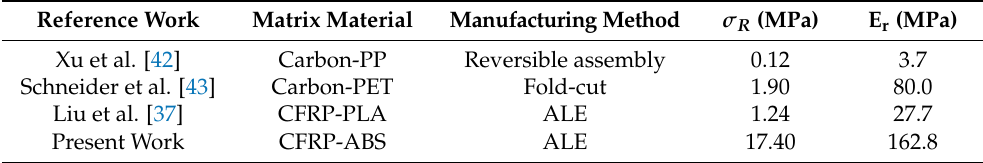
Table 3. Comparison of the present work with other existing truss lattice structures.